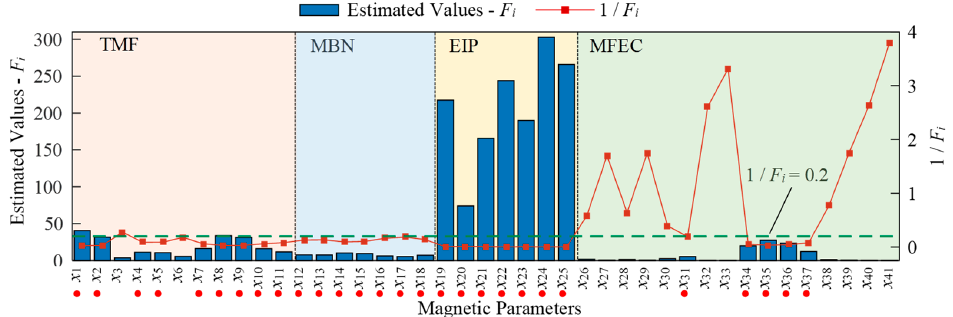
Figure 7. Estimated values of F i and 1/ F i for all the measured magnetic features.